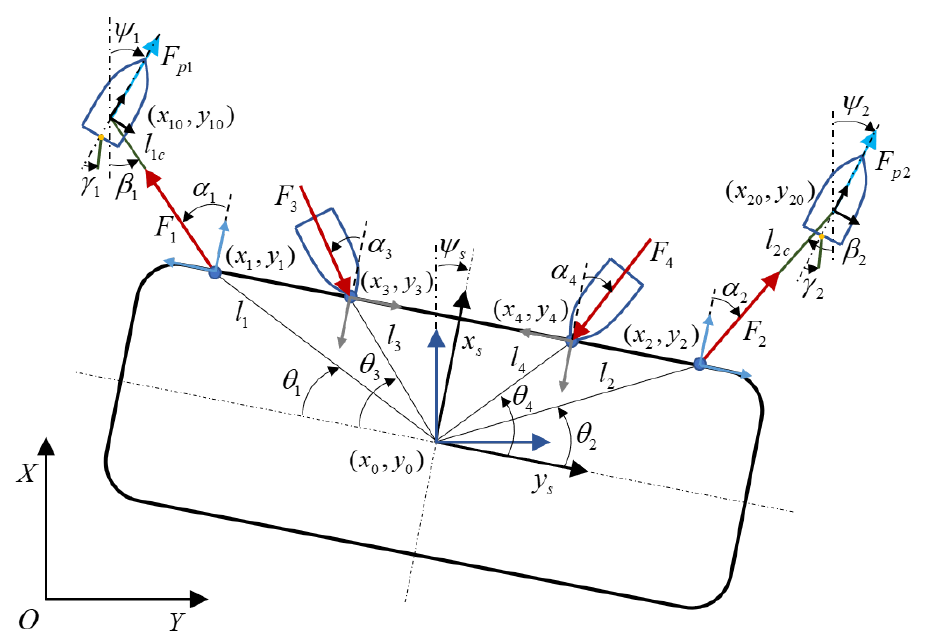
Figure 2. A schematic drawing and the coordinate definitions of the proposed system.